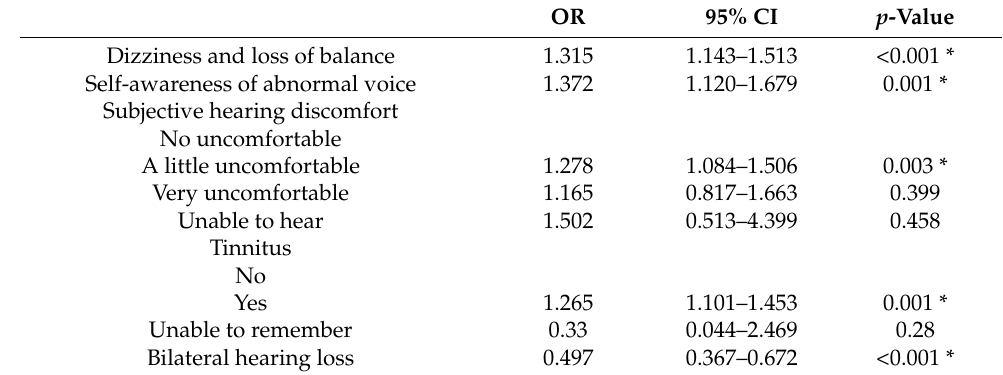
Table 3. Factors that affect dry eye after adjusting for age, gender, dizziness, self-awareness of abnormal voice, subjective hearing discomfort, tinnitus and bilateral hearing